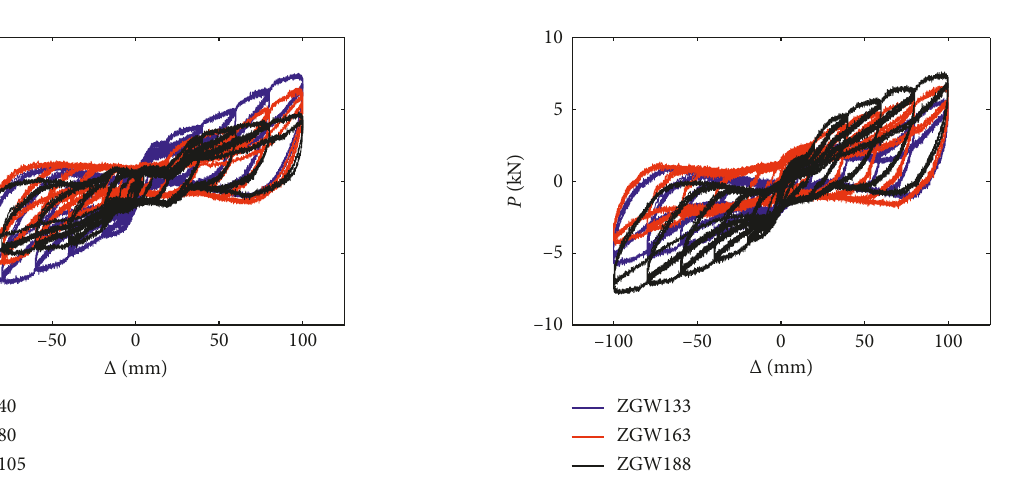
Figure 10: P - Δ hysteresis curve for circumferential column foot damage